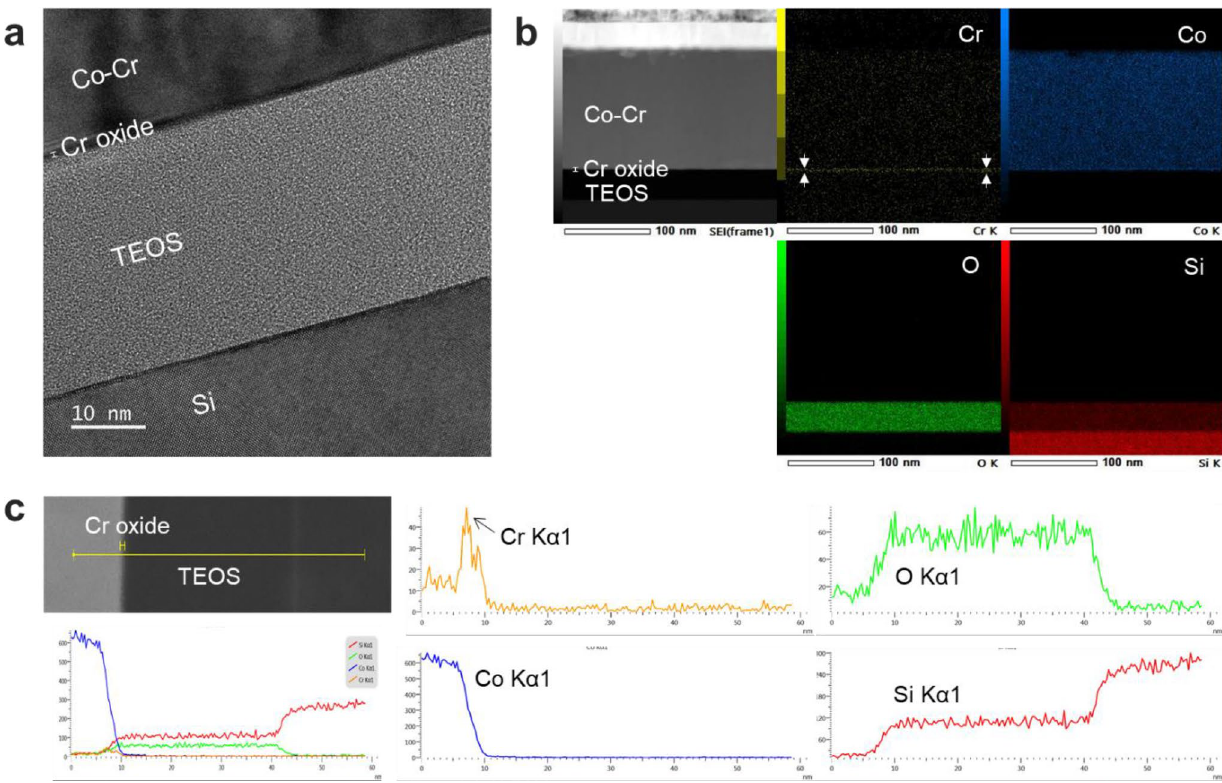
Figure 4. ( a ) High-resolution transmission electron microscopy (HR-TEM) images of Co-Cr MIS structure. ( b ) EDS mapping images; Co, Cr, O, and Si elements were analyzed at each interface. ( c ) EDS line